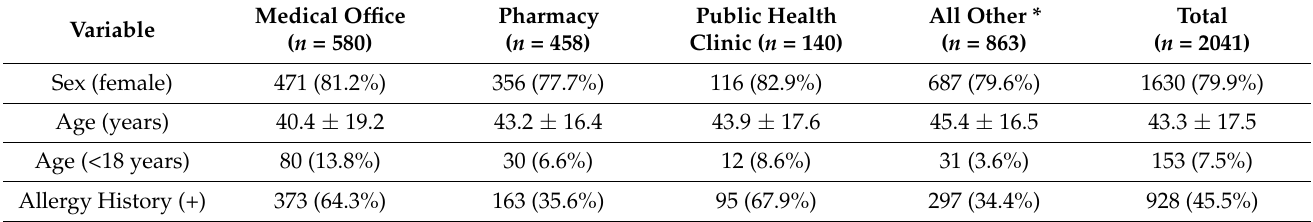
Table 1. Demographics and Outcomes of Post-Vaccination Anaphylaxis Reports by Administration Setting. Variable